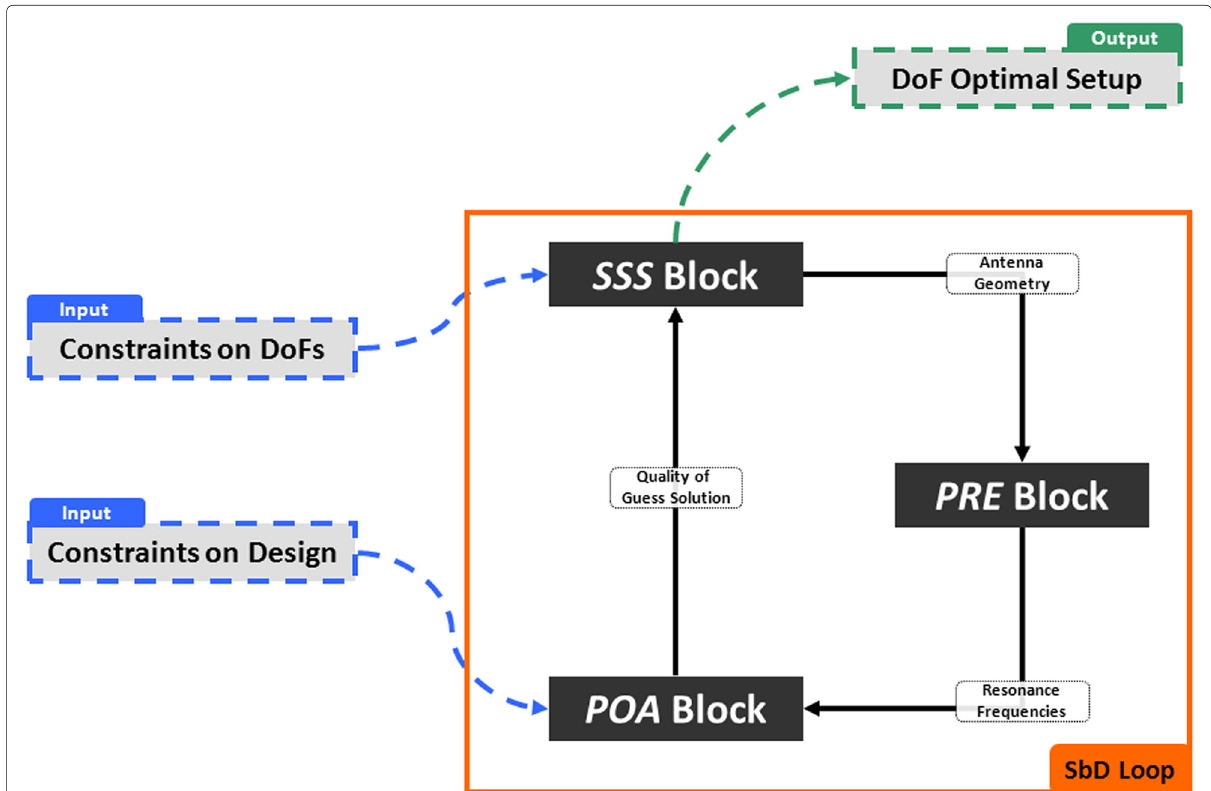
Fig. 1 SbD design procedure